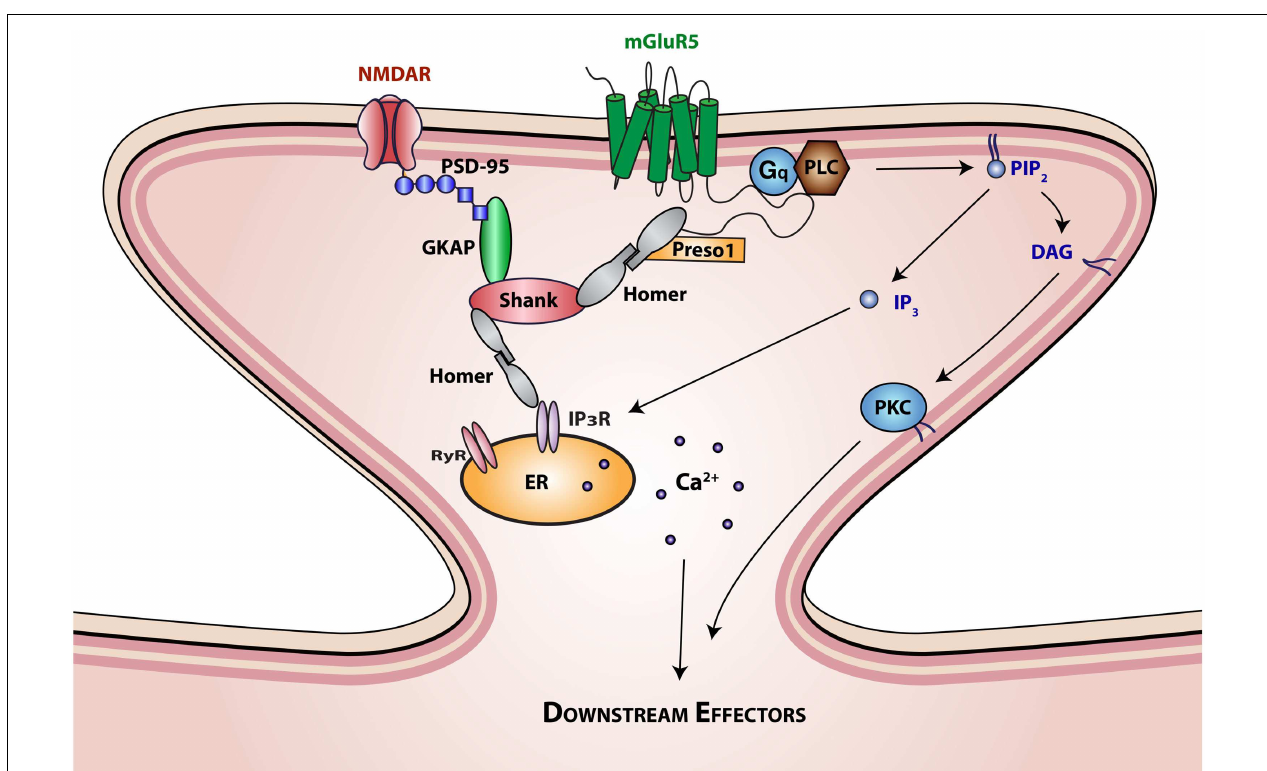
proteins. mGluR5 activation by glutamate initiates G q protein signaling that regulates the function of phospholipase C (PLC). Activation of PLC results in the hydrolysis of phosphatidylinositol-4,5-bisphosphate (PIP 2 ) to release the second messengers 1,2-Diacylglycerol (DAG) and IP 3 . DAG is the physiological activator of protein kinase C (PKC), which in turn activates various intracellular signaling cascades. IP 3 binds to intracellular IP 3 receptors (IP 3 R) on the endoplasmic reticulum (ER) membrane initiating Ca 2 + release from the ER lumen into the cytoplasm, generating complex Ca 2 + concentration-dependent signals, including temporal oscillations, and propagating